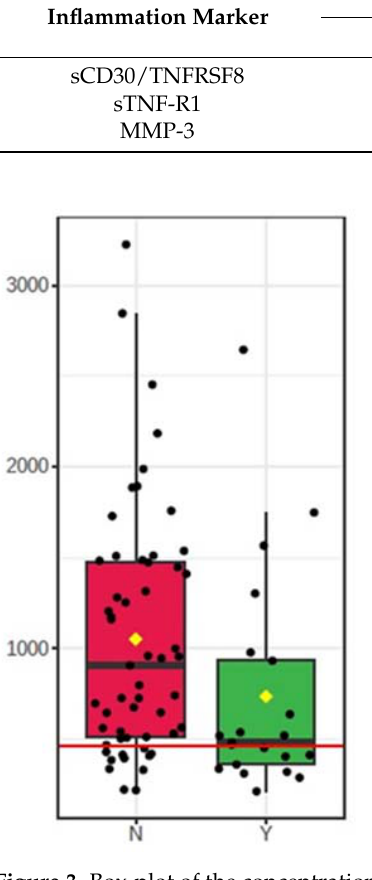
Figure 3. Box-plot of the concentrations of sCD30/TNFRSF8 53 in both groups. A horizontal line is in red, indicating the optimal cut-off. N—control group; Y—allergy group.